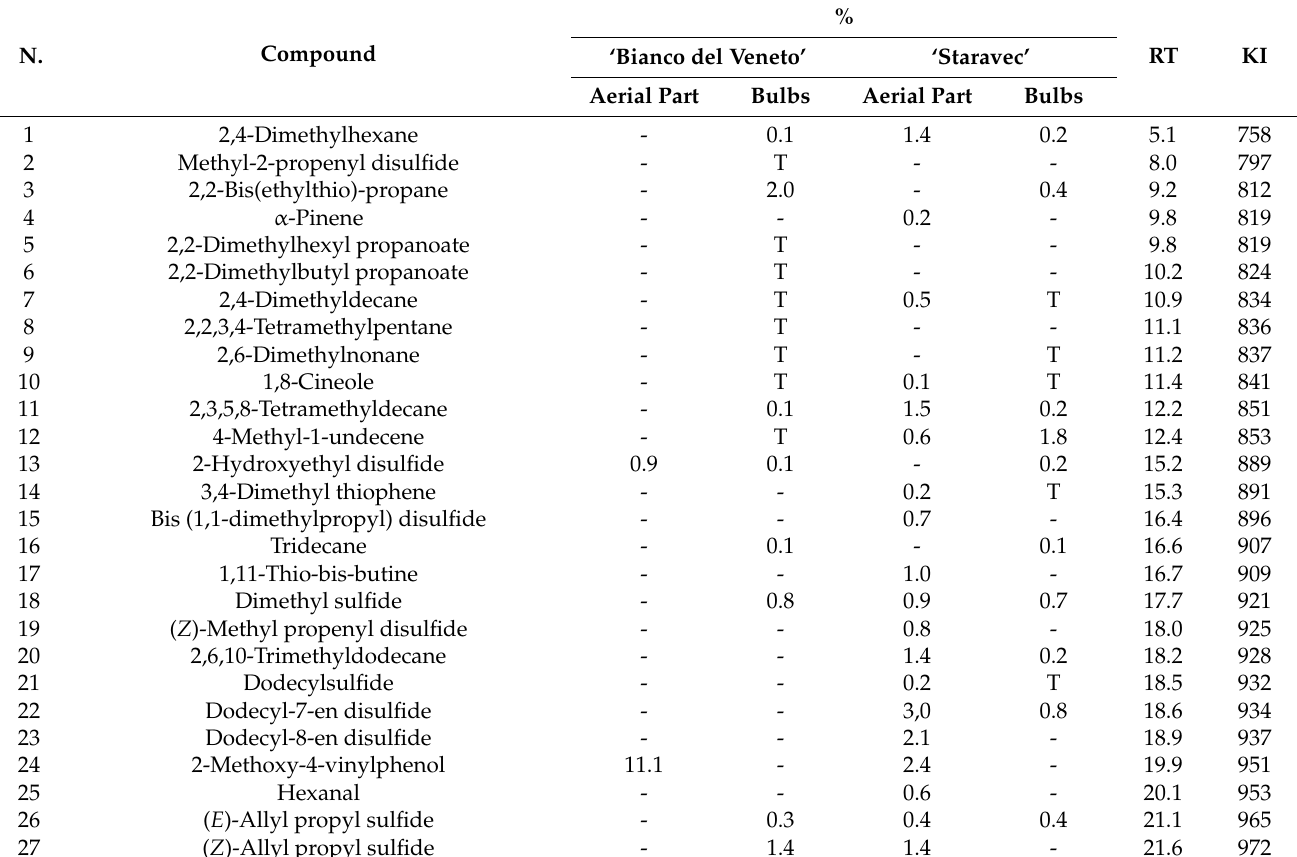
Chemical composition the EOs from the A. sativum cultivars ‘Bianco del Veneto’ and